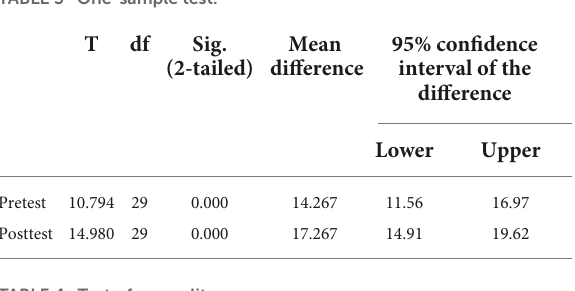
TABLE 3 One-sample test.